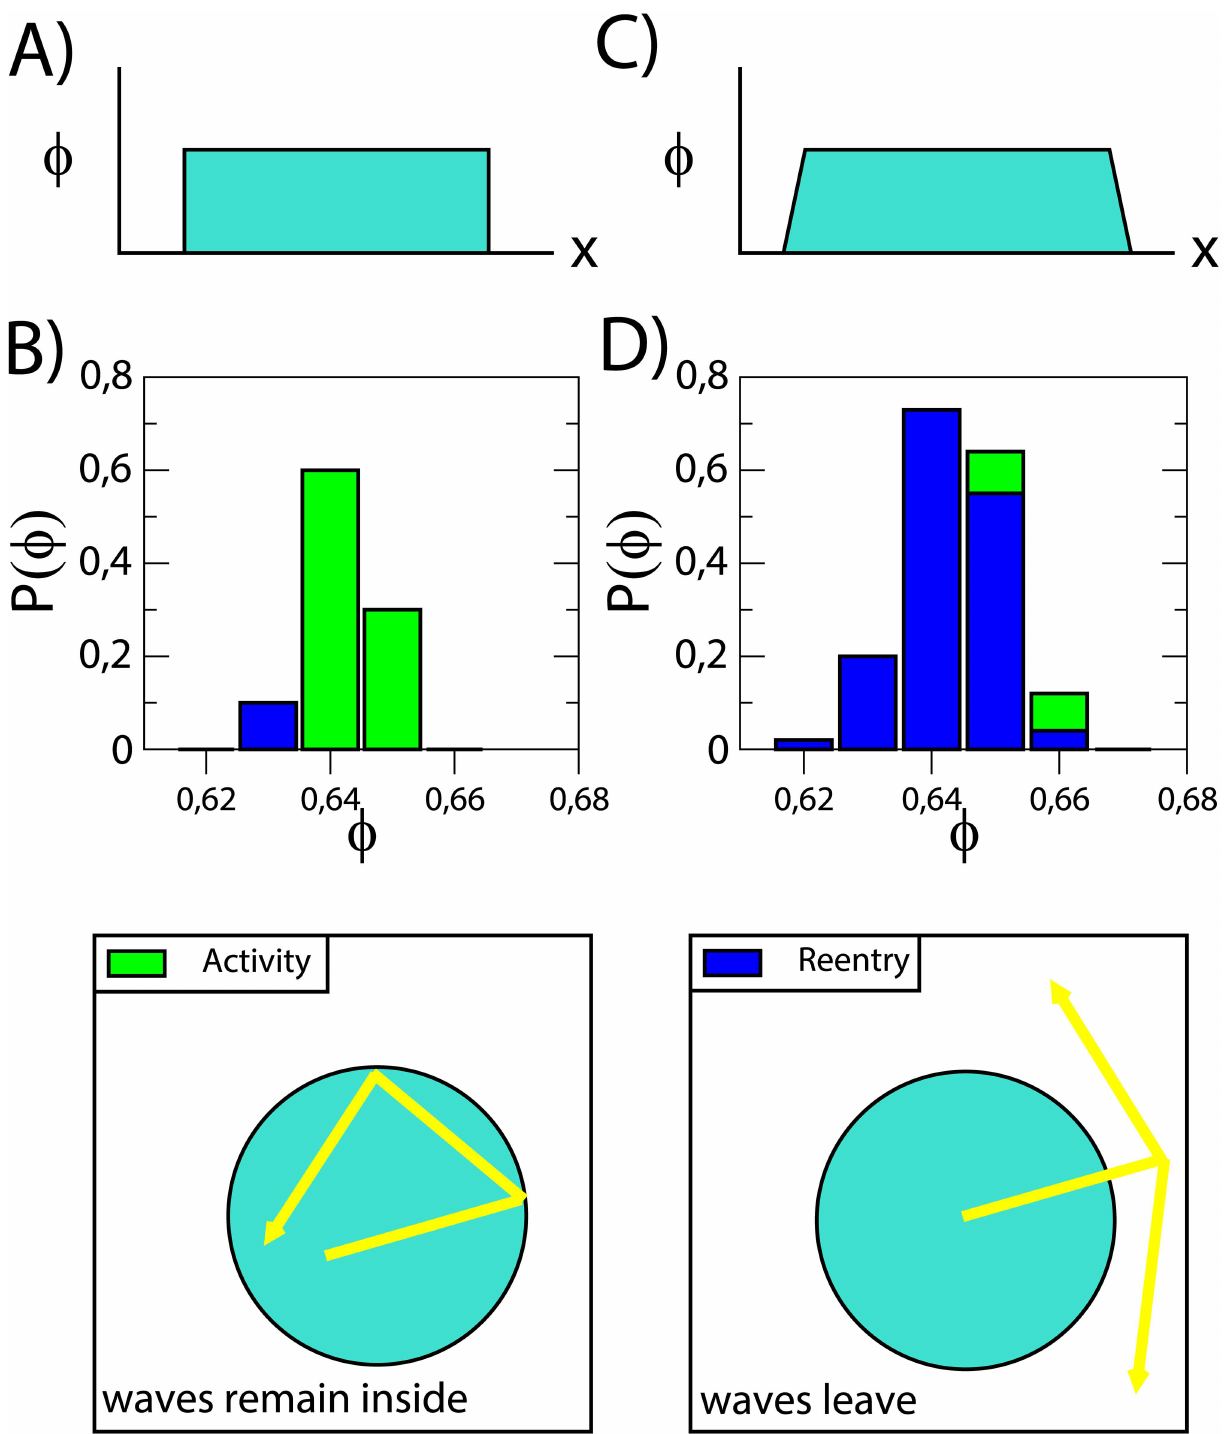
Fig 3. Effects of the fibrotic border in the fibrotic area. Sketch of the fibrotic regionwithout (a) and with (c) fibrotic border and probabilityof reentry without (b) and with (d) fibrotic border for N = 3 in a system 4 × 4 × 0.03 cm 3 and R 0 = 1.40 cm for a total time of simulationof 1500 ms . Two types of dynamicsare observed: reentry outside of the fibrotic region, Reentry (blue) or activity restricted to the interior of the fibrotic region, Activity (green).